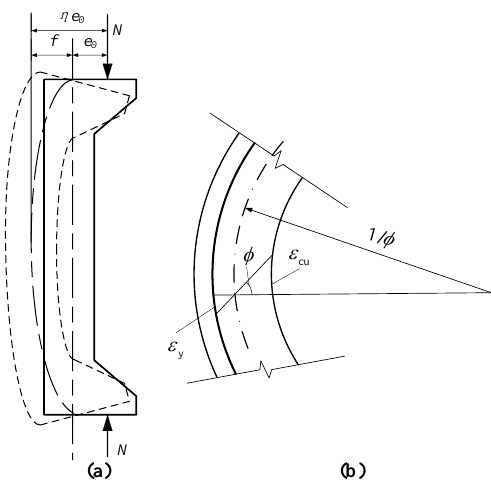
Figure 10. Schematic of the second-order effect: (a) additional eccentricity and (b) amplification factor.